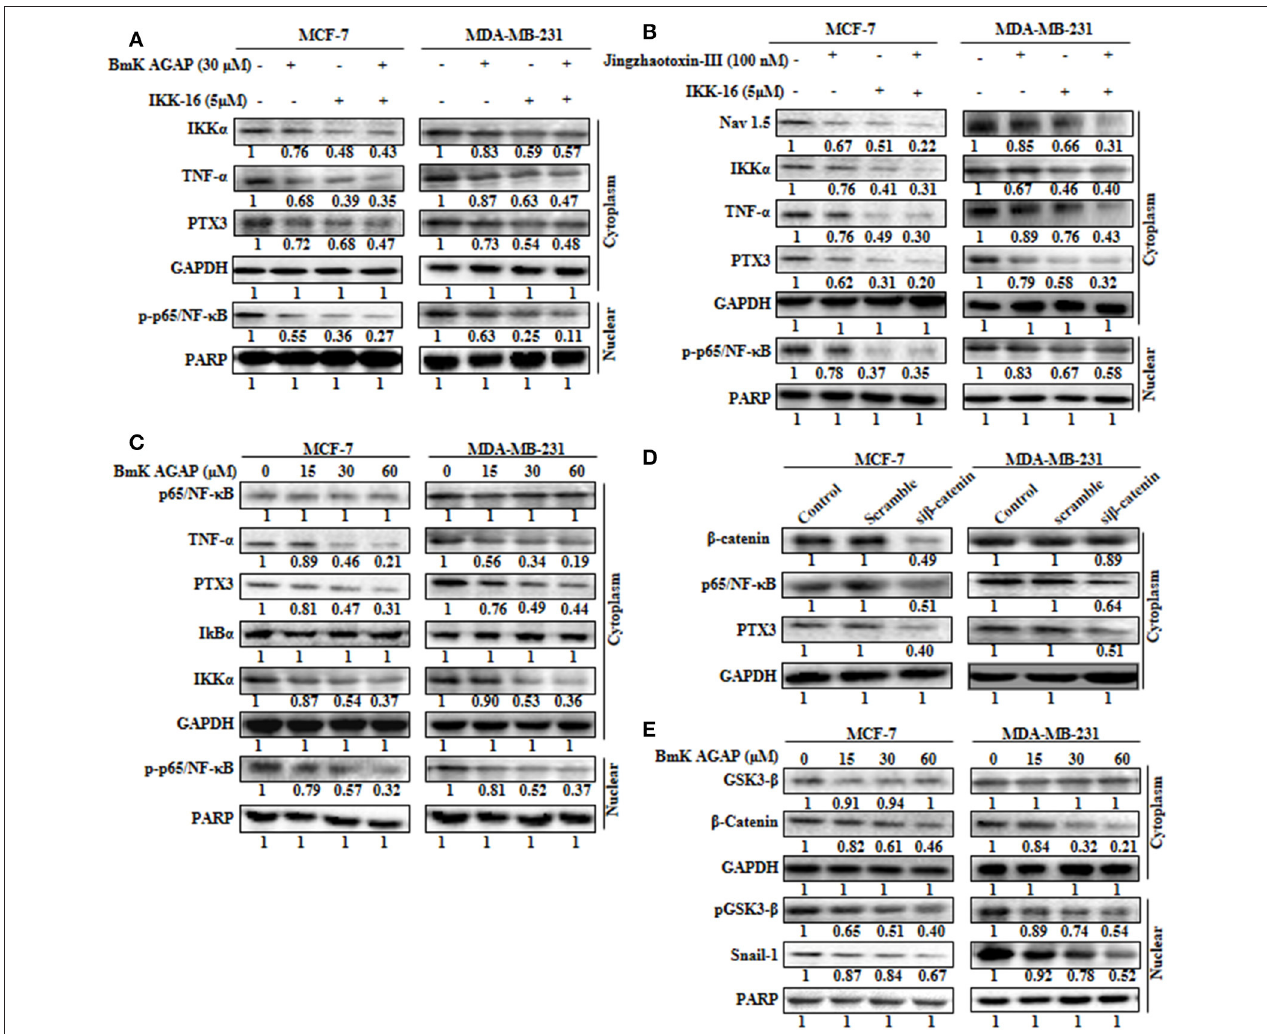
FIGURE 6 | Nav 1.5 is involved in BmK AGAP mediated down-regulation of PTX3 via NF- κ B and Wnt/ β -catenin signaling pathway. (A) rBmK AGAP or IKK-16 impairs NF- κ B pathway, TNF- α , and PTX3. MCF-7 and MDA-MB-231 cells were treated with either rBmK AGAP (30 µ M) or IKK-16 (5 µ M) for 48h. The cells were lysed and subjected to 12% SDS-PAGE and analyzed by western blotting with antibodies against IKK α , p-p65/NF- κ B, TNF- α , and PTX3. The data indicated decreased expression of IKK α , p-p65/NF- κ B, TNF- α , and PTX3. (B) Inhibition of Nav 1.5 or IKK α suppresses PTX3, NF- κ B activation, and TNF- α . Jingzhaotoxin-III or IKK-16 was used to treat MCF-7 and MDA-MB-231 cells for 48h. The cells were then lysed and subjected to 12% SDS-PAGE and analyzed by western blotting with antibodies against Nav 1.5, IKK α , TNF- α , PTX3, and p-p65/NF- κ B. The data showed decreased expression of Nav 1.5, IKK α , TNF- α , PTX3, and p-p65/NF- κ B following the inhibition of Nav 1.5 or NF- κ B. (C) rBmK AGAP suppresses NF- κ B activation, PTX3, and TNF- α in breast cancer. MCF-7 and MDA-MB-231 cells were treated with different concentrations of rBmK AGAP for 48h. Cells were lysed and subjected to SDS-PAGE and analyzed by western blotting with antibodies against p65/NF- κ